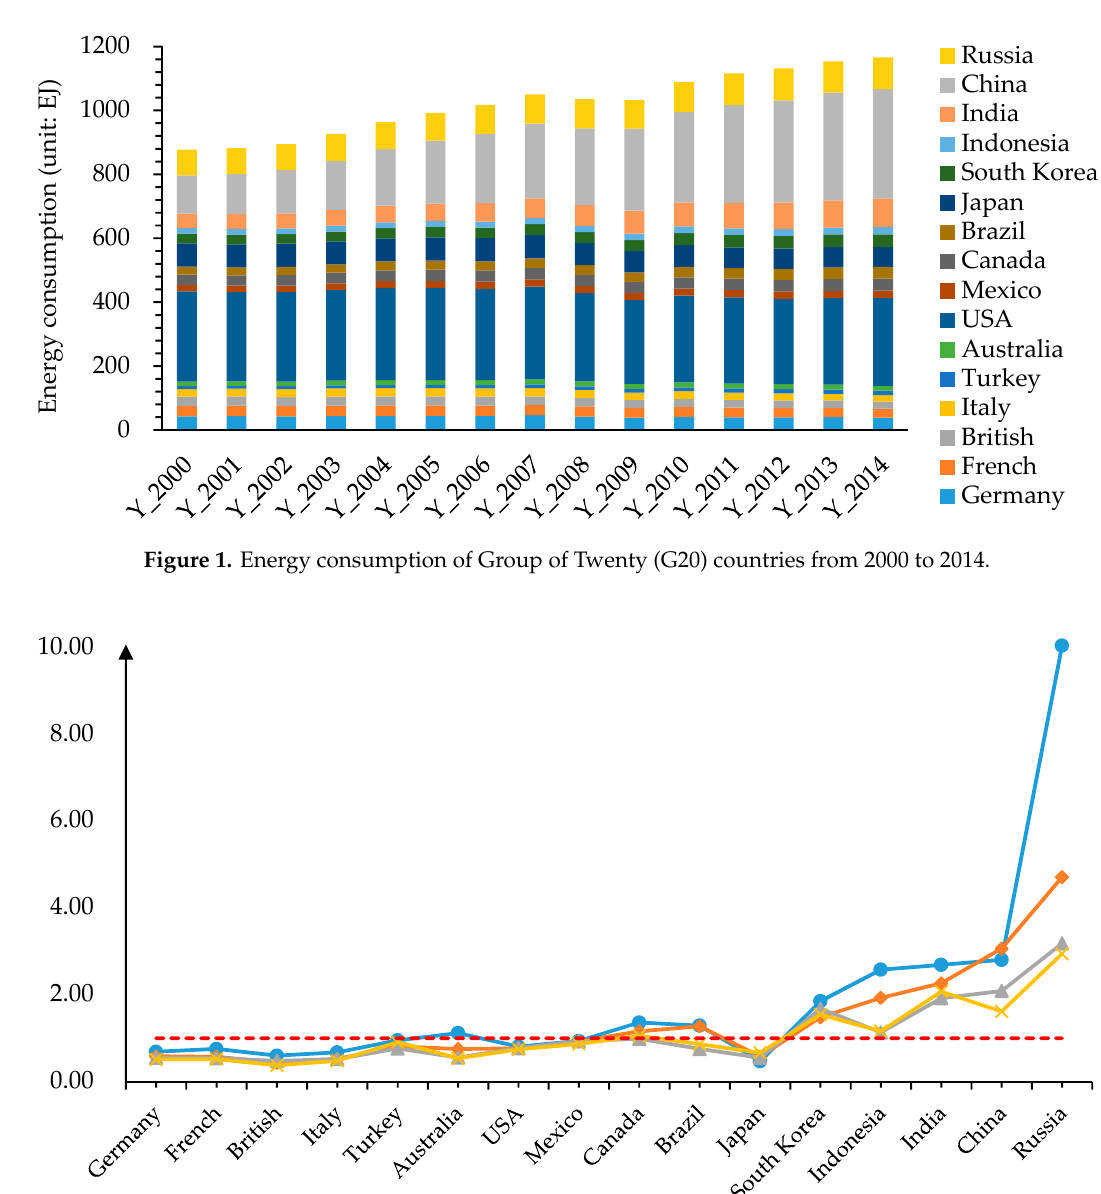
Figure 2. Ratio of G20 countries and groups average energy intensity.